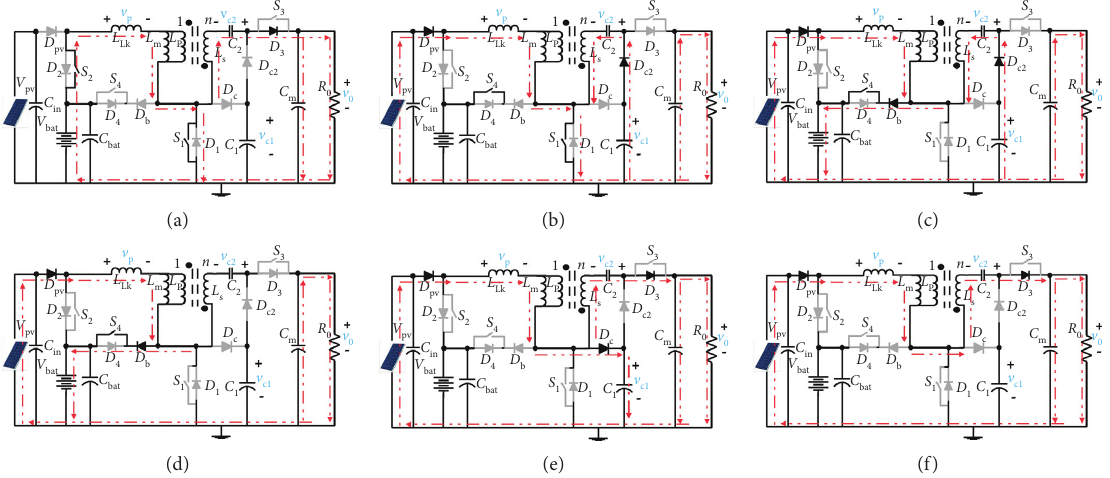
Figure 6: Steady-state equivalent circuits and current flow of the converter in SIDO mode. (a) t t ∼ t . (f) t ∼ t 4 5 5 6